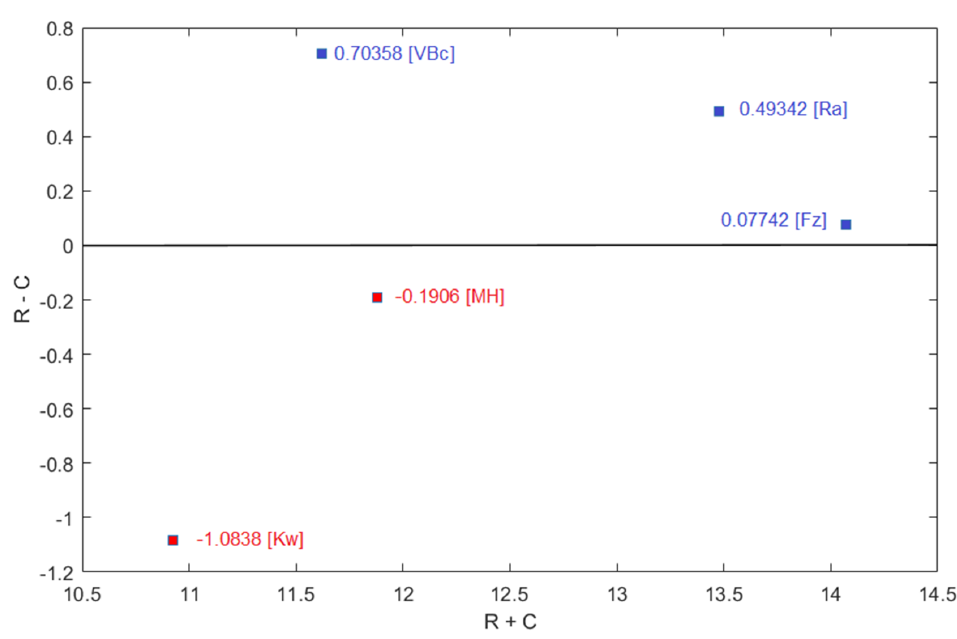
Fig. 2. DEMATEL causal diagram for the output